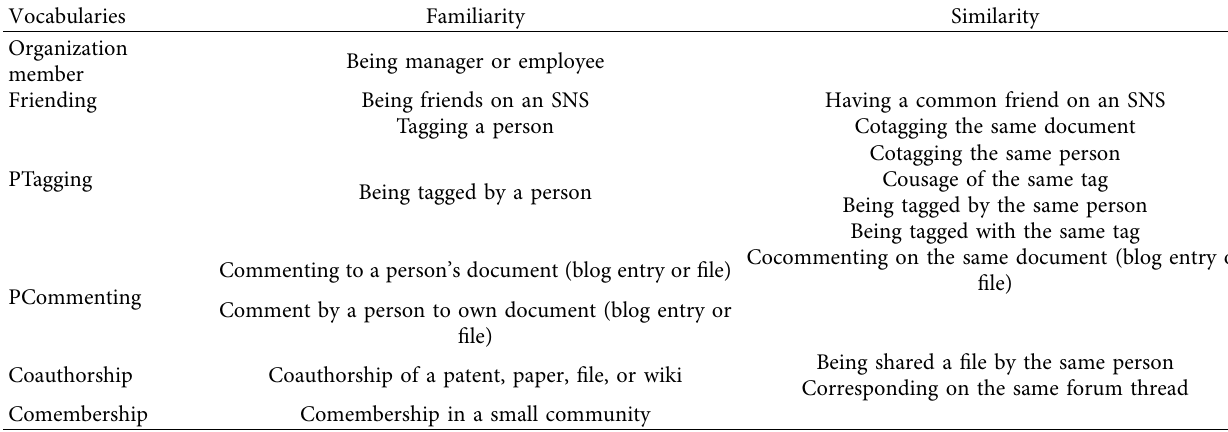
Figure 6: Structure of social relationship graph views. Table 1: People-people